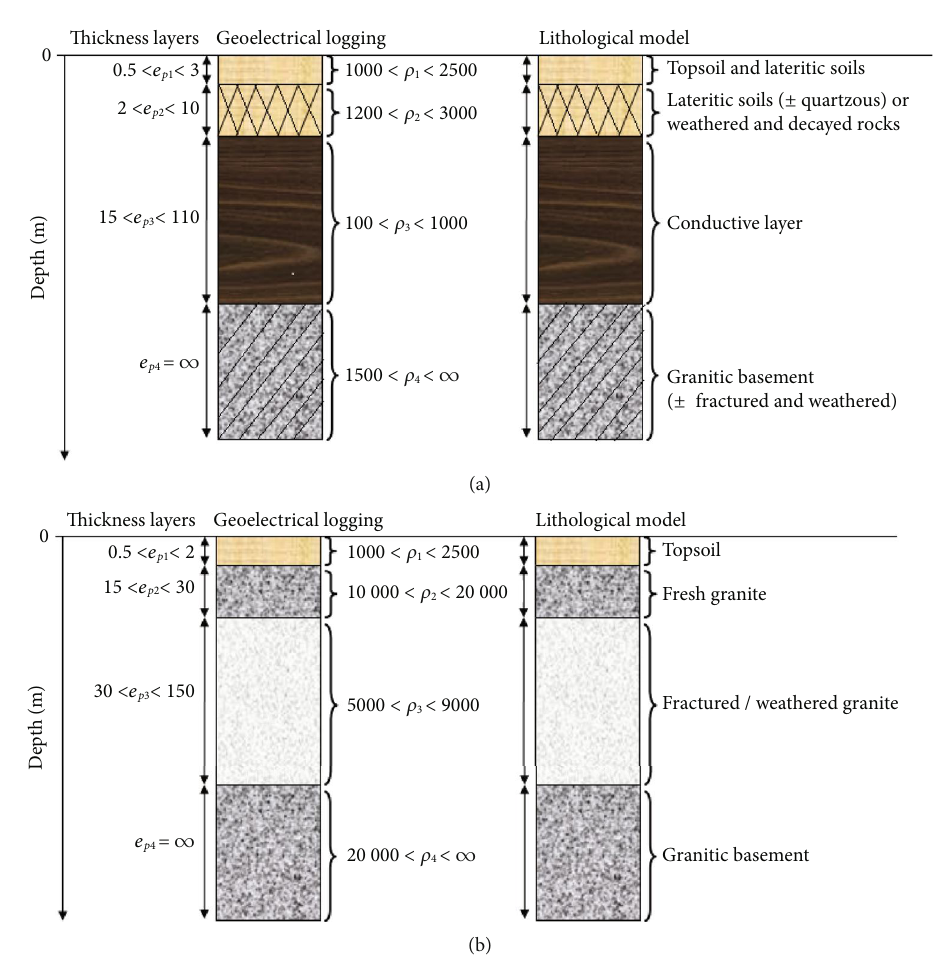
Figure 24: (a, b) Lithological models of the sounding curves of type KH.